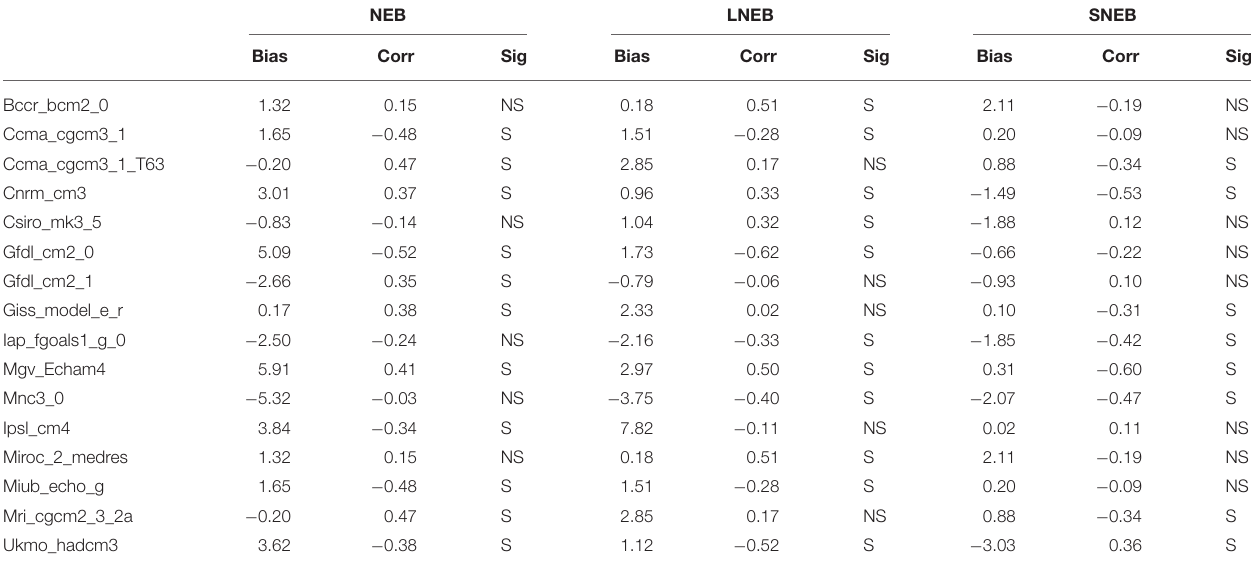
TABLE 4 | Correlation and bias between the autumn rainfall simulated by the CMIP5 models and observations in CMAP. NEB LNEB SNEB Bias Corr Sig